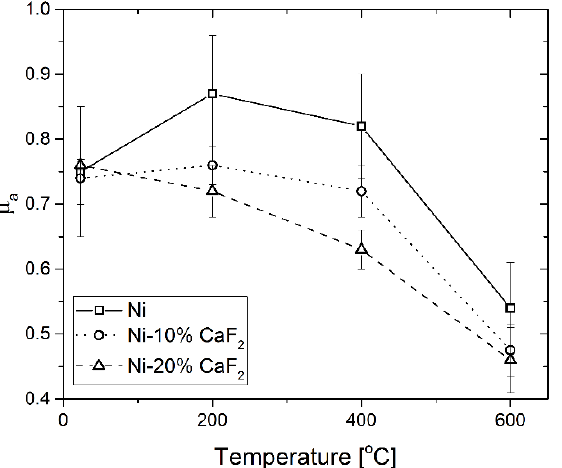
Figure 1. The average values of the friction coefficient ( µ a ) vs. temperature of friction for pure Ni, sintered Ni-10% CaF 2 and sintered Ni-20% CaF 2 self-lubricating composite mating with Inconel ® 625-alloy. Results for pure Ni and for 20% addition of CaF 2 were taken from previous work [43] and added for data clarity.